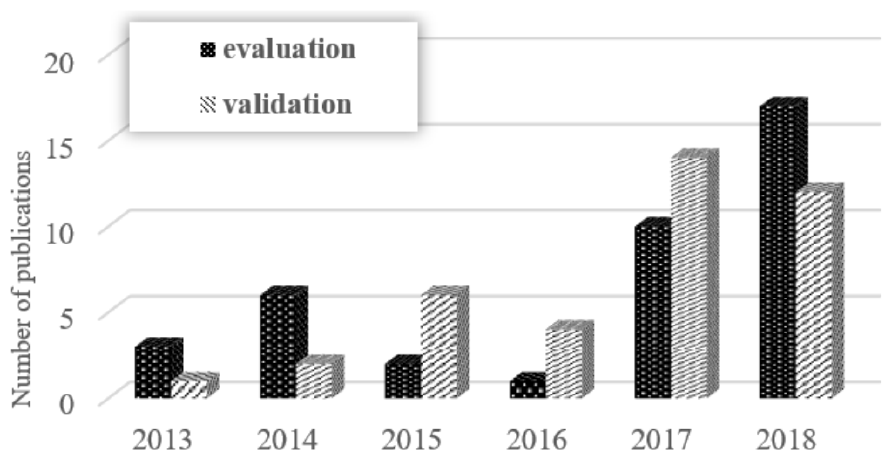
Figure 10. Popularity of research types by year (stable reports until early